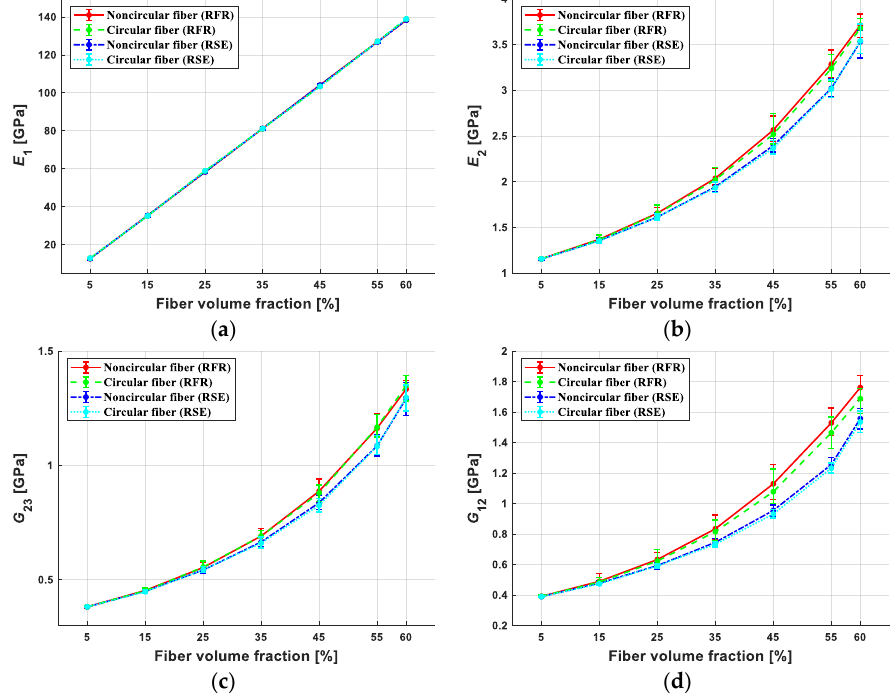
Figure 8. Effective elastic properties: ( a ) E 1 , ( b ) E 2 , ( c ) G 23 , and ( d ) G 12 of T300 / PR319, with V f ranging from 5% to 60%.